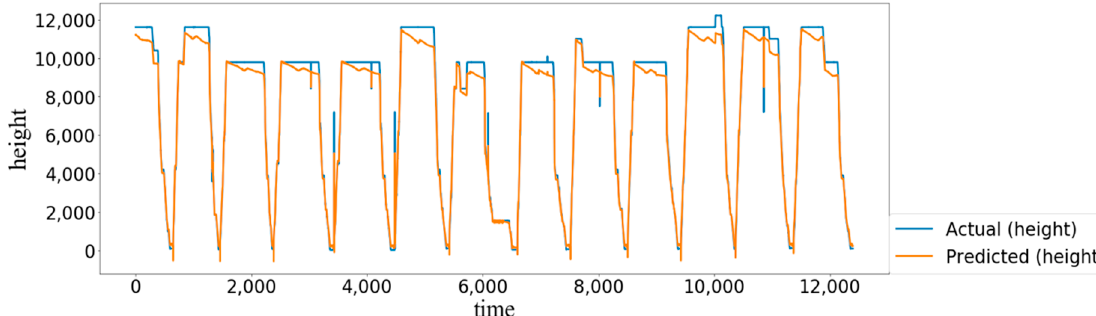
Figure 5. The Prediction of Height.